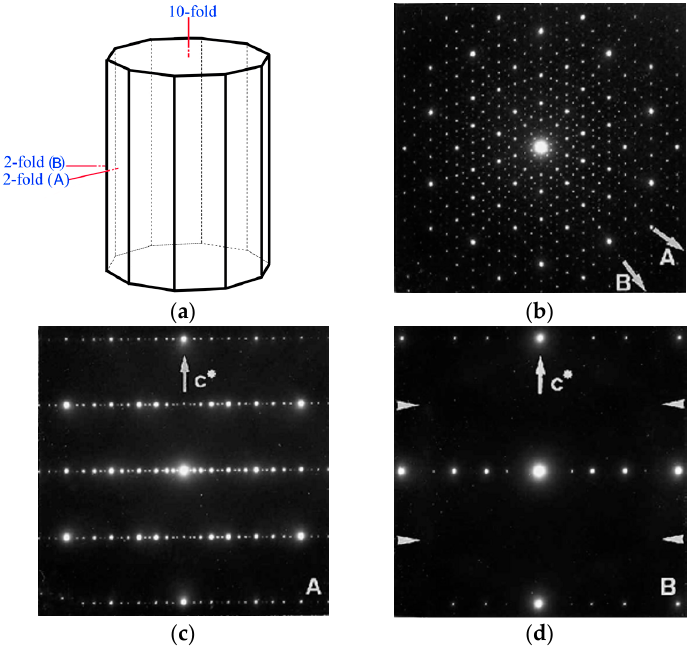
Figure 2. Decagonal structure: ( a ) schematic of decagonal structure; SAED patterns taken along ( b ) 10-fold symmetry axis, ( c ) 2-fold symmetry axis A and ( d ) 2-fold symmetry axis B of Al 70 Ni 20 Rh 10 (reproduced from reference [31] with permission).